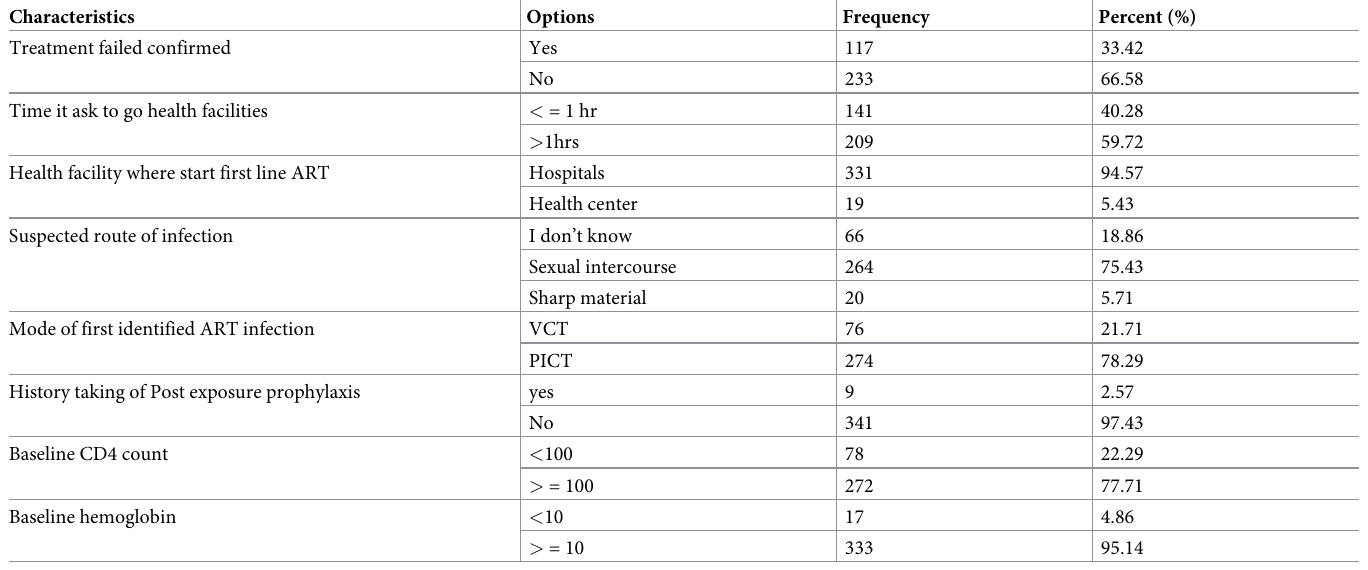
Table 4. Health care facility, laboratory result and patient related condition of patients taking ART drugs at ART at public health facilities in South West Shoa Zone, 2019.